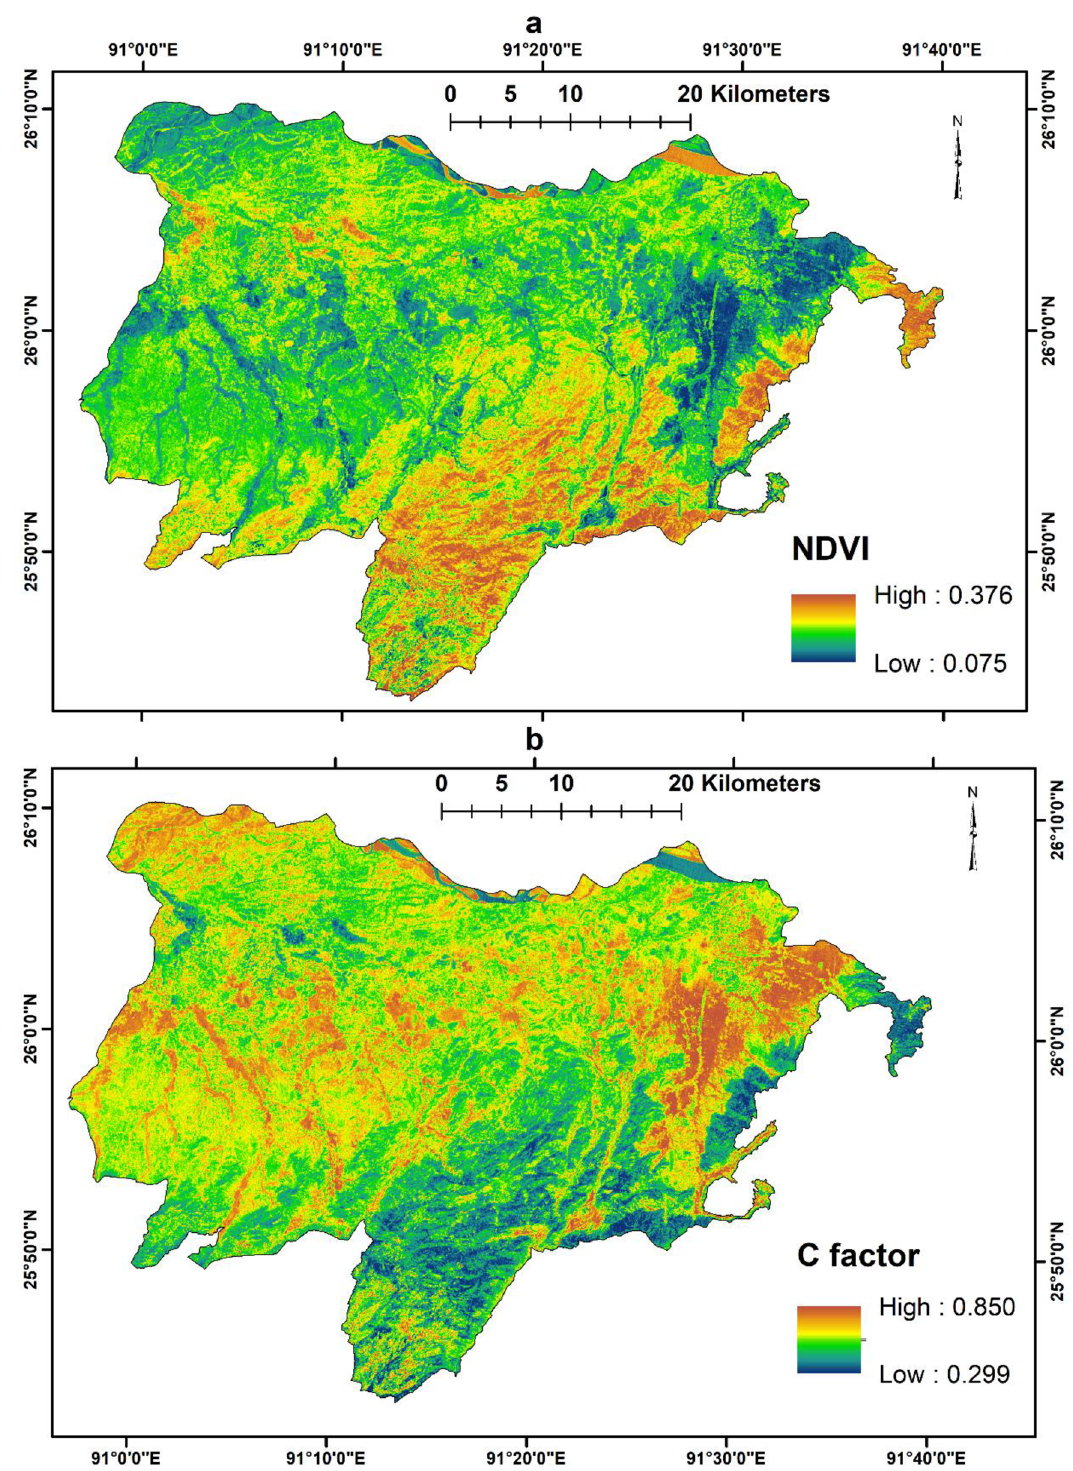
Fig. 5 a Normalized difference vegetation index map, b C factor